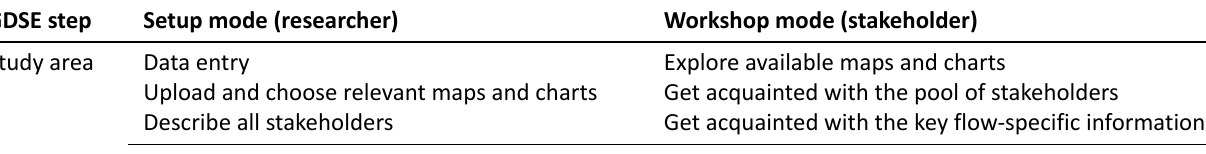
Table 1. Steps and capabilities of the GDSE in Setup mode (only accessible for researchers) and Workshop mode (used by the stakeholders).